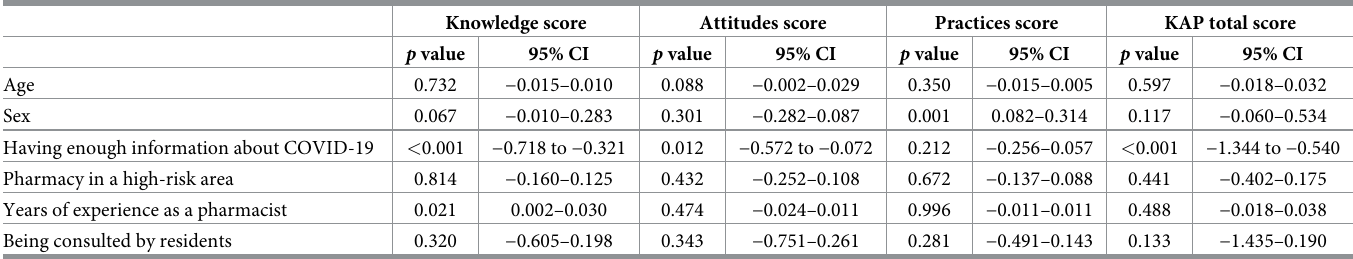
Table 5. Factors influencing individual and total KAP scores associated with COVID-19 in multiple regression